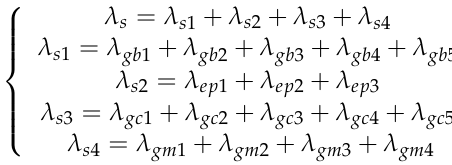
Figure 5. Modules and components of the motor controller.